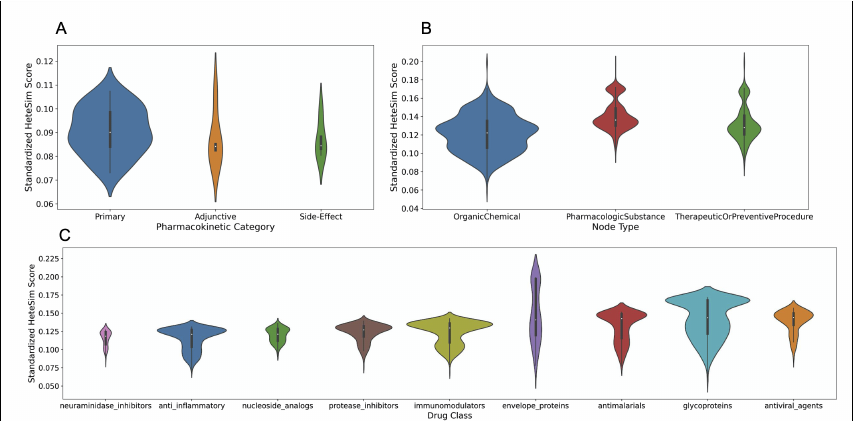
Figure 10. ( A ) Violin plot showing the distribution of standardized HeteSim scores between each pharmacokinetic label. Lower HeteSim score means a closer relationship between the source node and tail node. ( B ) Violin plot showing the distribution of standardized HeteSim scores between each node type. ( C ) Violin plot showing the distribution of standardized HeteSim scores between each drug